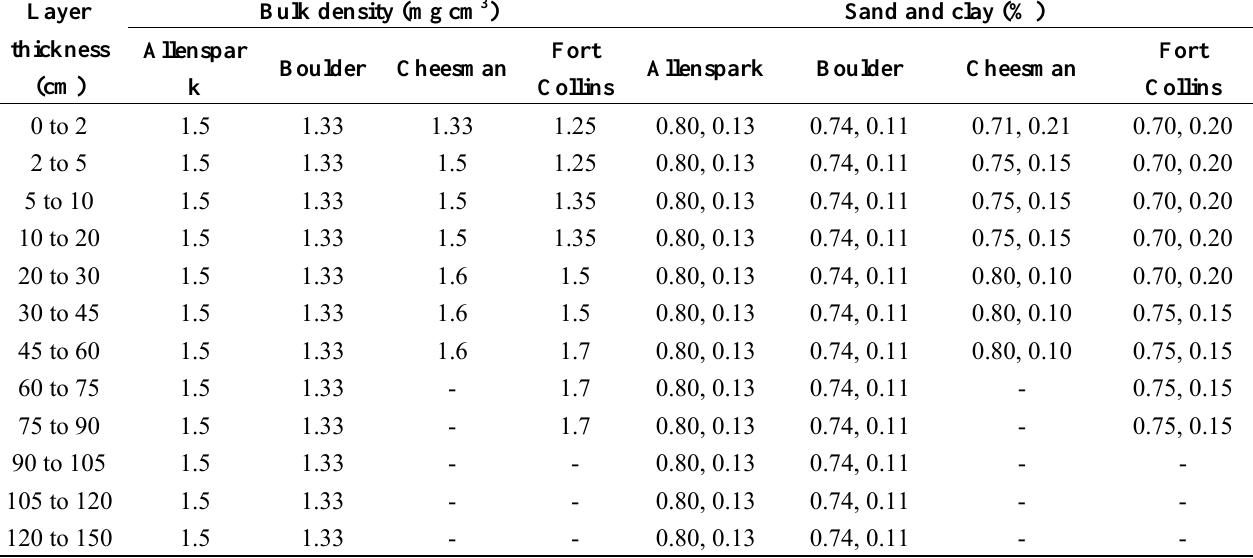
Table 3. A description of the site specific soil parameters used for each of the four simulated locations. Data shown include the number and thickness of soil layers, bulk density, and soil texture. Site specific soils data were retrieved from the United States Department of Agriculture—Natural Resource Conservation Service’s Web Soil Survey [25]. Layer Bulk density (mg cm 3 ) Sand and clay (%) Fort Fort Boulder Cheesman Allenspark Boulder Cheesman Collins